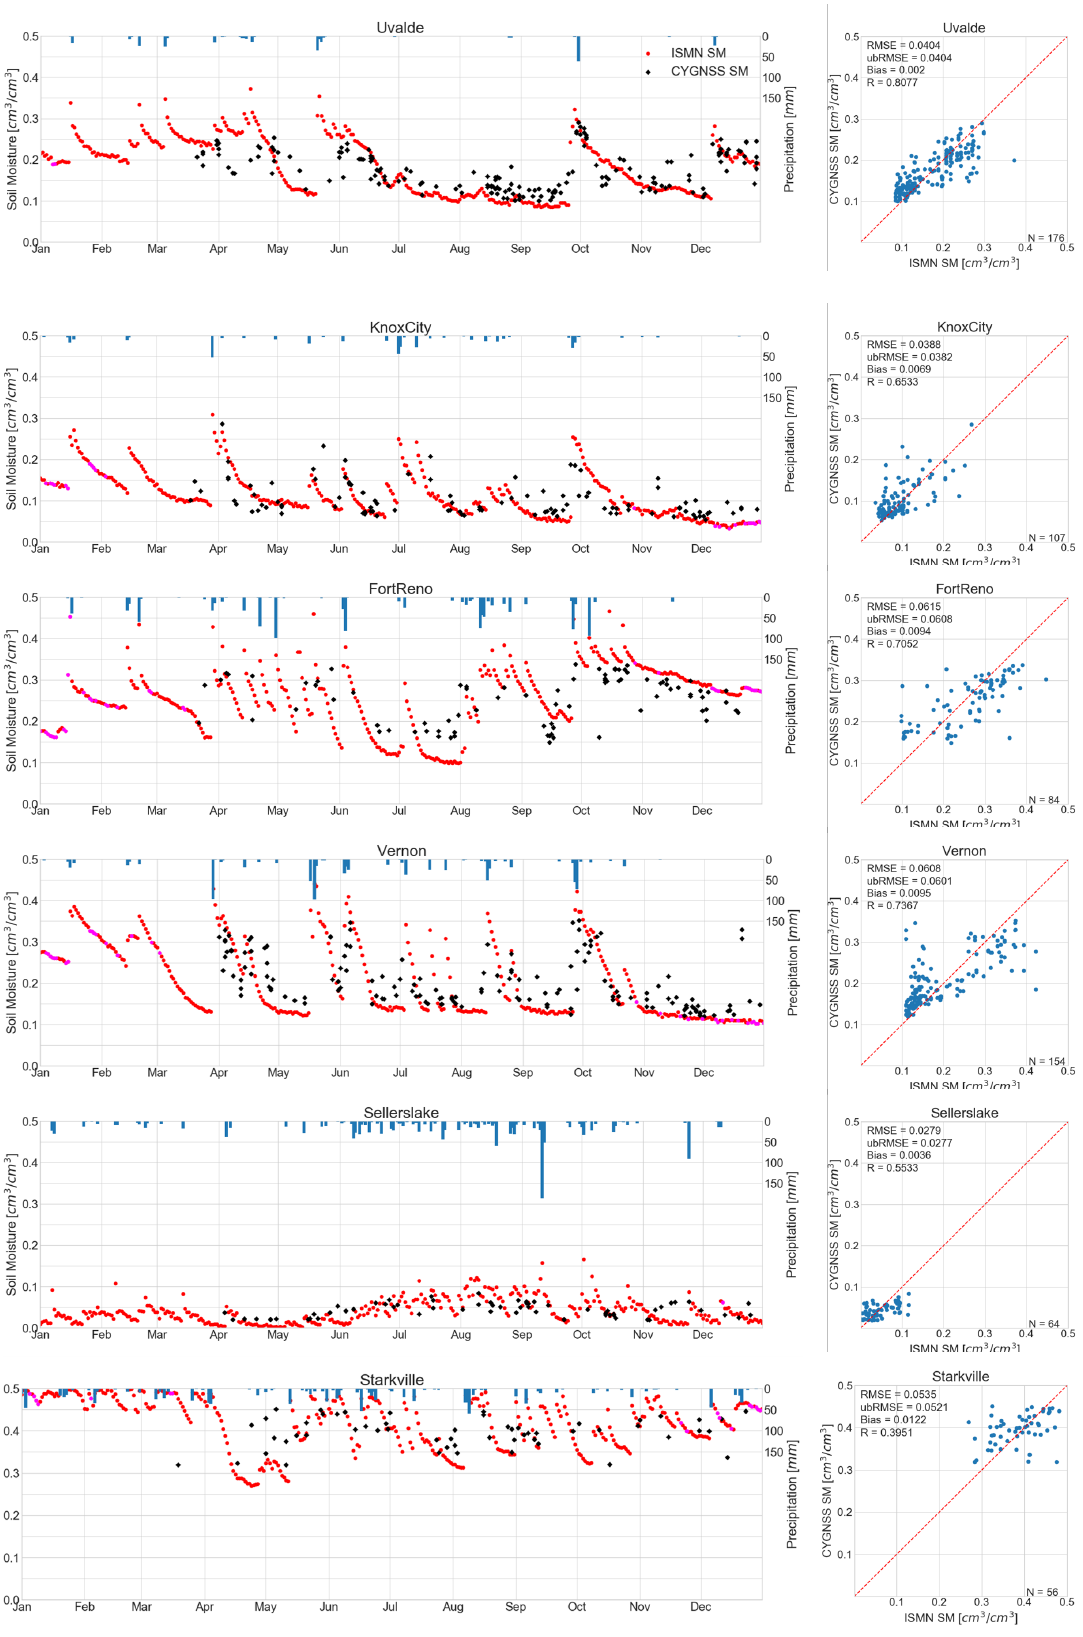
Figure 9. SM retrievals for 2017. In situ SM data are color-coded such that magenta and blue circles correspond to days with freeze temperatures and invalid data, respectively. Scatter plots are also